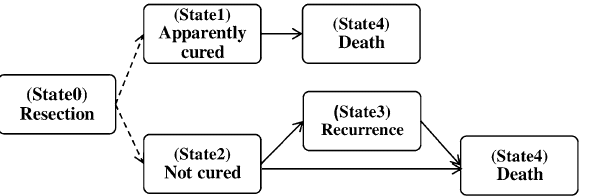
Figure 4. Multi-state cure model structure. The arrows show the directions of possible transitions (N =